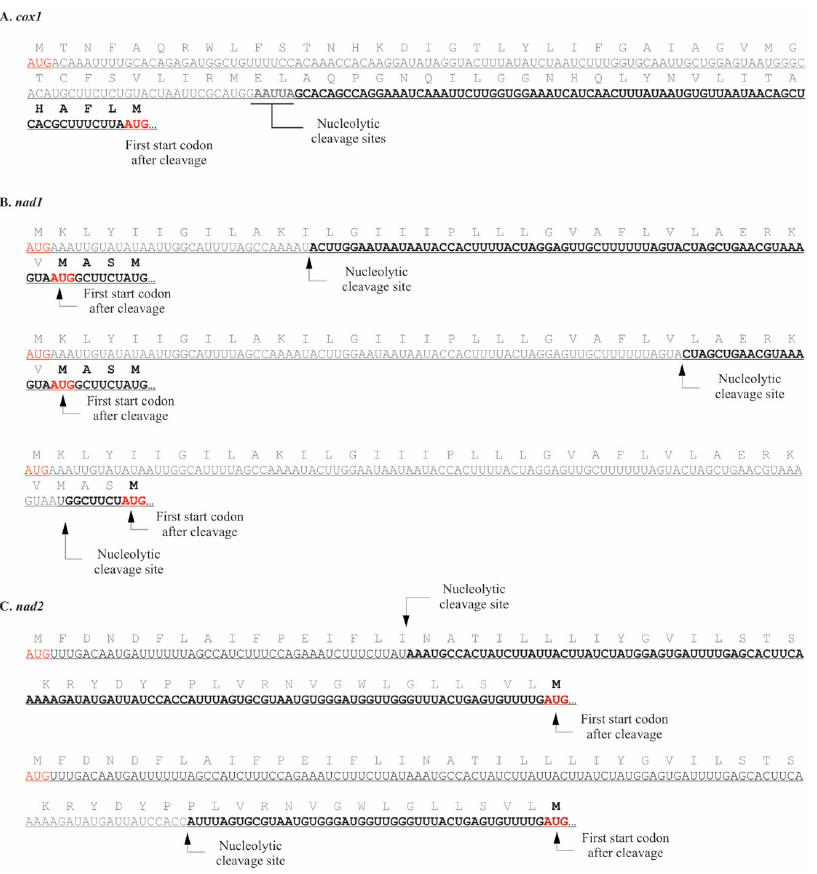
Figure 5. The 5 (cid:48) termini and UTRs of three C. vulgaris mitochondrial mRNAs where the 5 (cid:48) terminus occurred downstream of predicted start codons. Start codons are red and truncated portions of coding regions grey. ( A ). For cox1 several 5 (cid:48) termini were detected within a 5-nucleotide region. ( B ). Three 5 (cid:48) termini were detected for nad1 . ( C ). Two different termini were detected for nad2 .